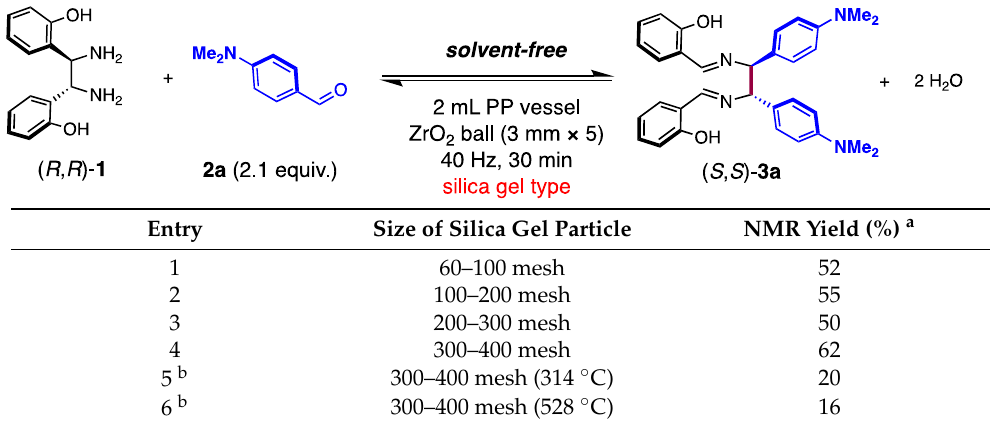
Table 2. Silica gel size effect and thermal activation effect on mechanochemical DCR reaction between mother diamine ( R , R )- 1 and 2a .